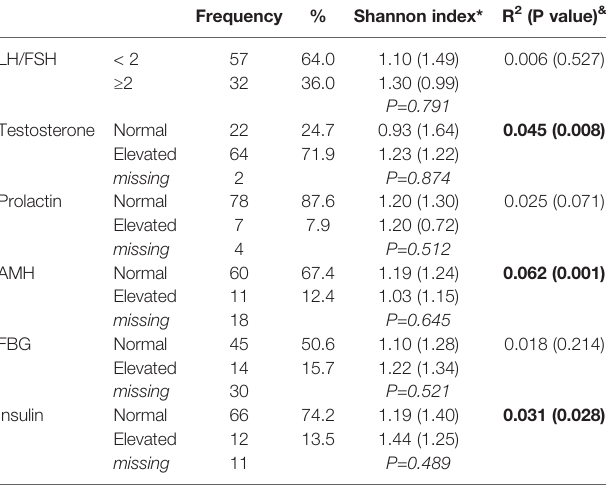
TABLE 2 | Clinical features of PCOS and associations with vaginal microbiota. Clinical features